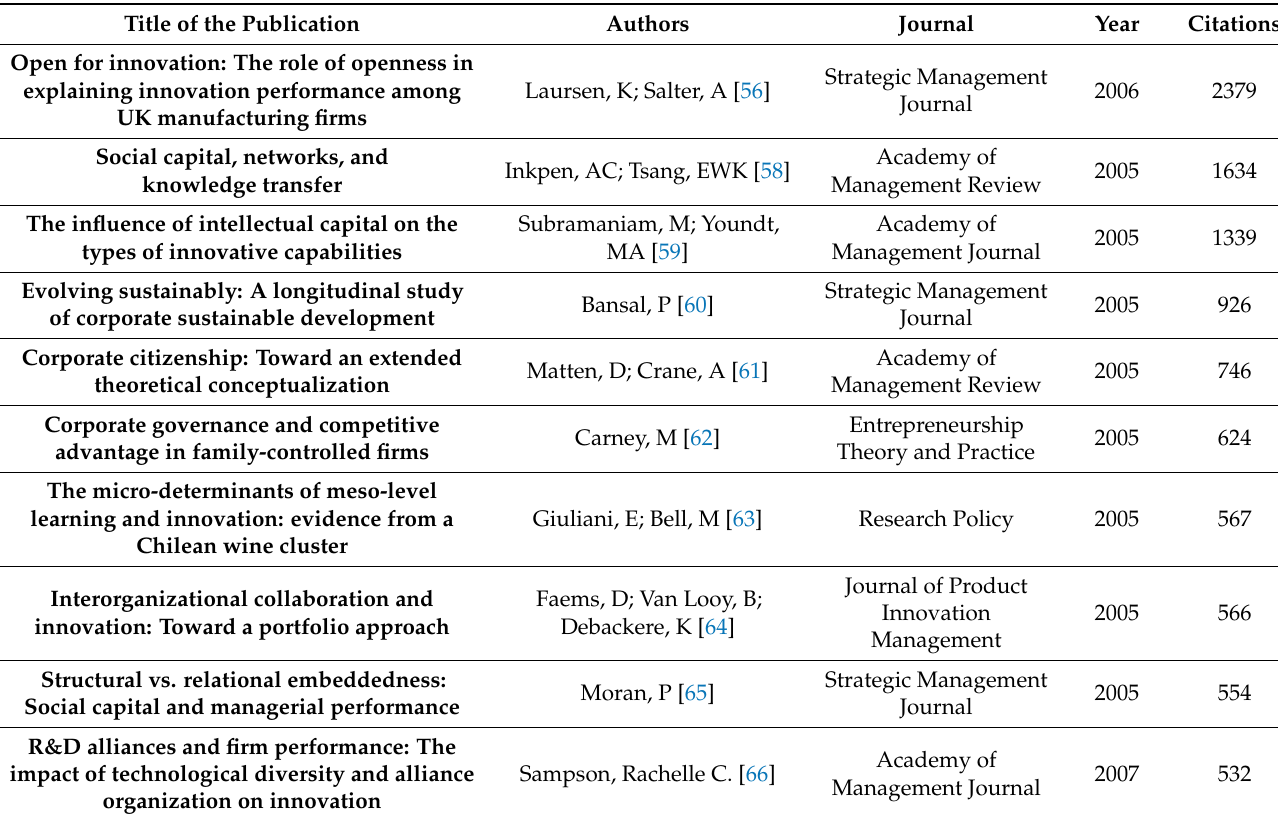
Table 2. Top 10 publications (Source: Own